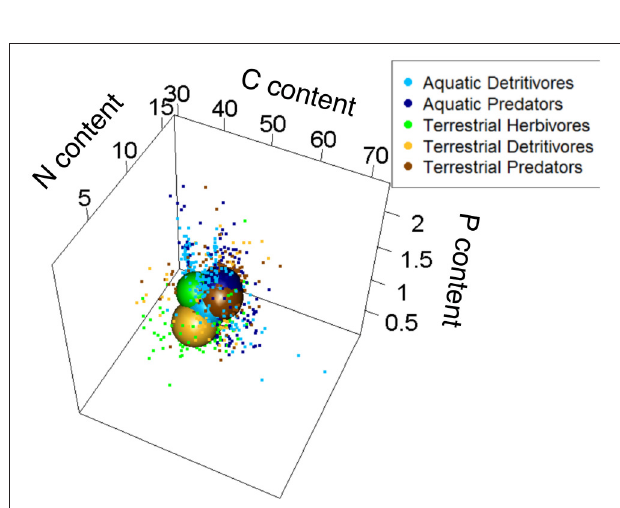
FIGURE 7 | Relative size of stoichiometric niche volumes of aquatic and terrestrial trophic groups (only invertebrates included). Sphere sizes depicts the volumes of the various grouping variables, and are centered around the average C, N, and P contents of all individuals from those variables. Dots are individual coordinates and show the variability within a given grouping variable. Axes represent each element as a percentage of dry body